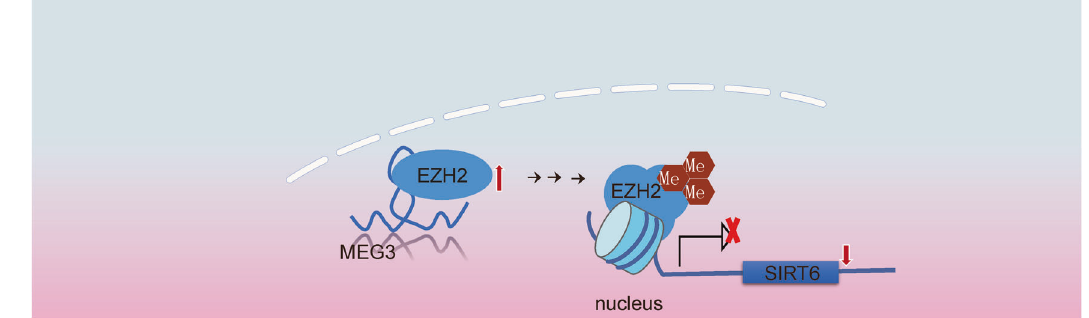
Fig. 6 A cartoon image summarizing the major fi ndings of this